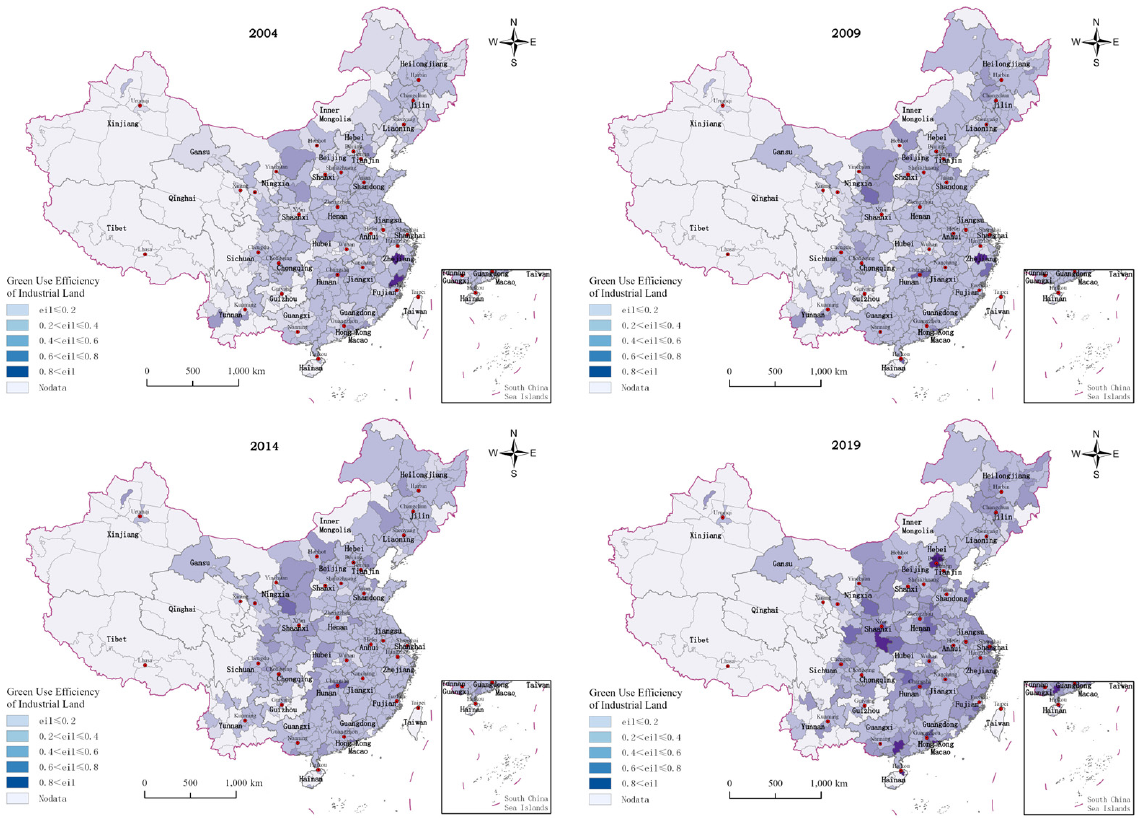
Figure 4. Spatial distribution of GUEIL in China from 2004–2019.